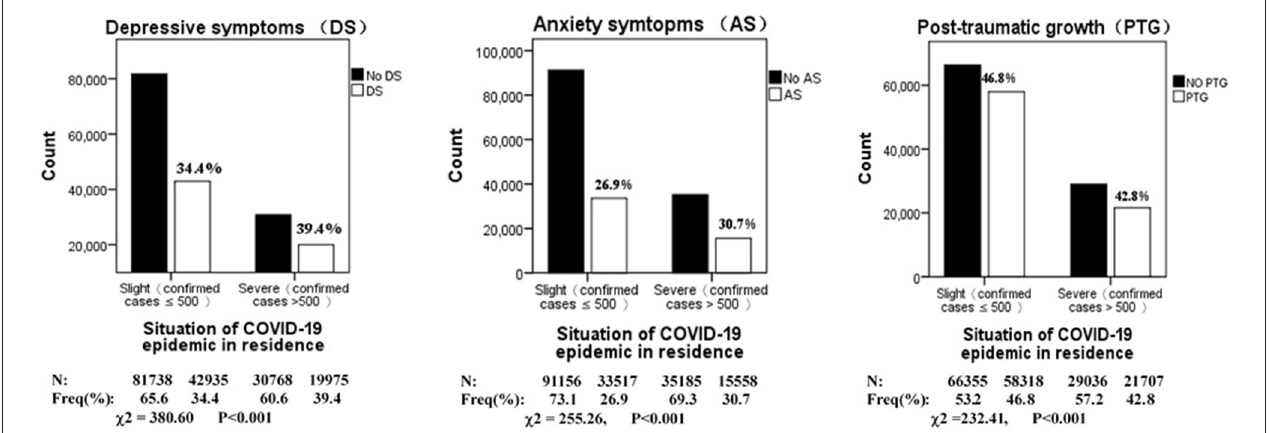
FIGURE 1 | Prevalence of depression, anxiety and PTG during COVID-19 outbreak in China, stratified by situation of COVID-19 epidemic in residence ( N = 175,416).